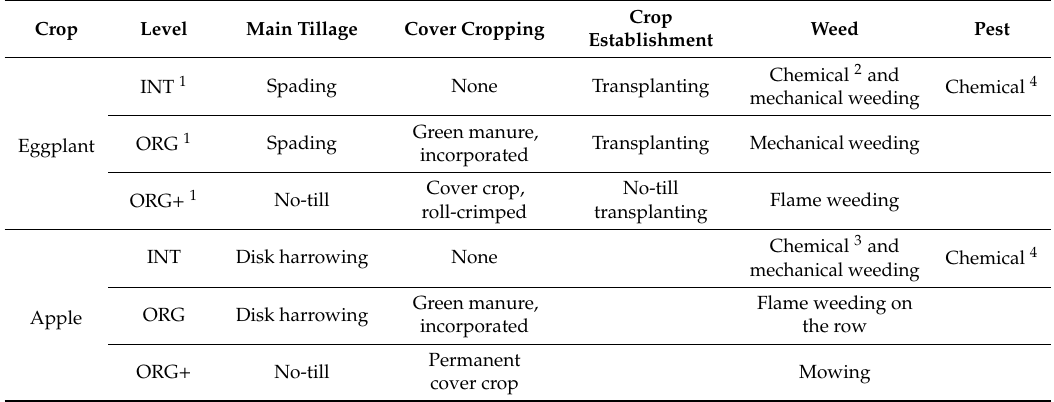
1 INT: integrated farming system, ORG: organic cropping system, ORG + : organic conservation system; 2 glyphosate 30.4% (3 dm 3 ha − 1 ) before the soil tillage, pendimethalin 31.7% (2.5 dm 3 ha –1 ) before the transplanting, and